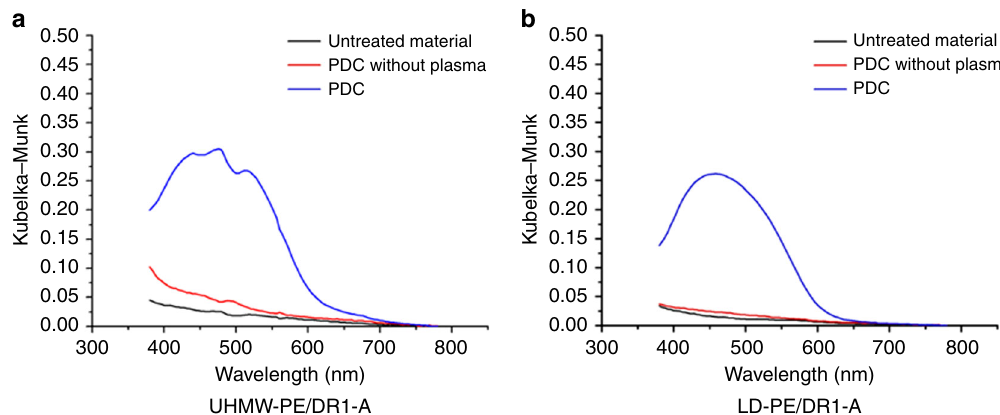
Fig. 8 Re fl ective UV-VIS spectroscopy on UHMW-PE and LD-PE. a The Kubelka – Munk, normalized at max. re fl ection, for non-treated (untreated material), PDC without the plasma treatment step (PDC without plasma), and a PDC-treated (PDC) sample of fi brous UHMW-PE/DR1-A, performed under following PDC conditions: plasma time: 1 min, dipping concentration: 25 mg/mL, and dipping time: 1 min. b The Kubelka-Munk, normalized at max. re fl ection, are given for non-treated (untreated material), PDC without the plasma treatment step (PDC without plasma), and a PDC-treated (PDC) sample of non- fi brous LD-PE/DR1-A, performed under following PDC conditions: plasma time: 1 min, dipping concentration: 25 mg/mL, and dipping time: 1 min